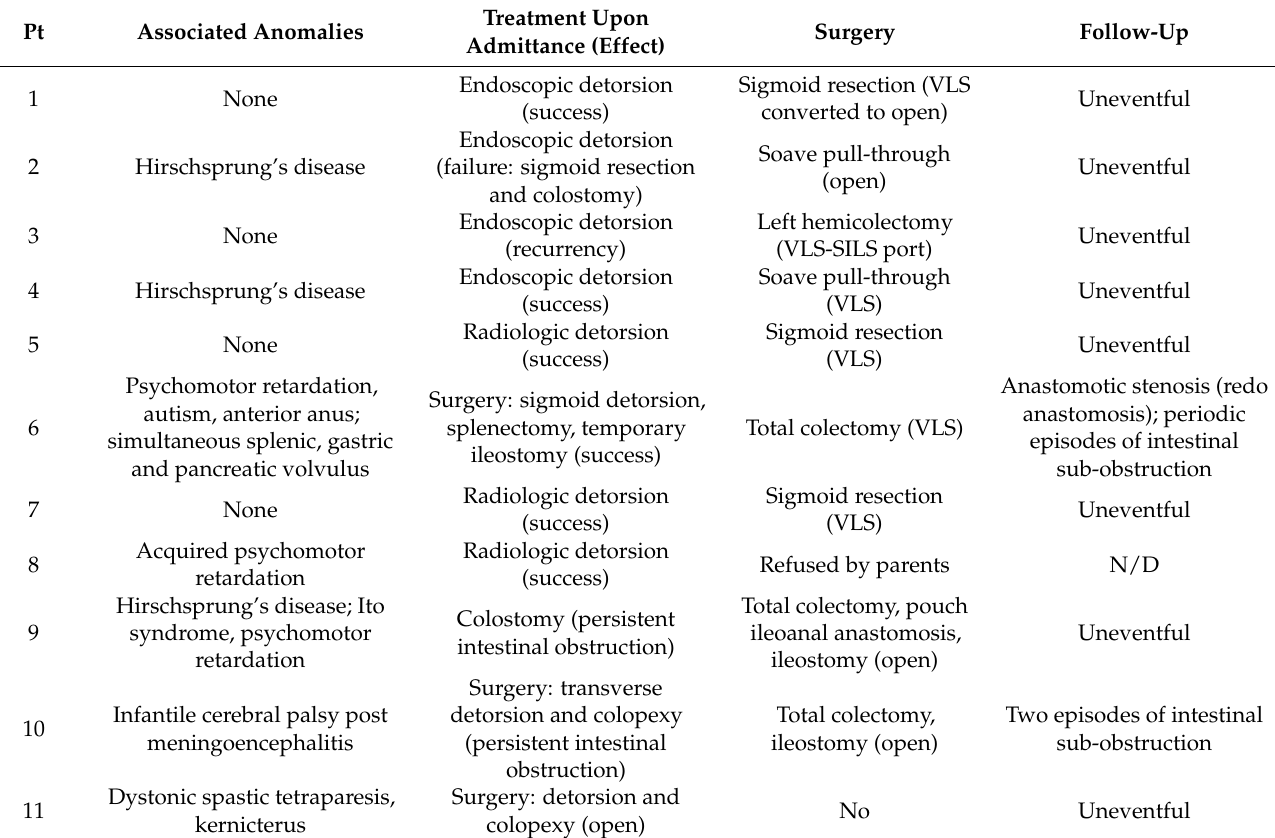
Table 3. Management of patients and